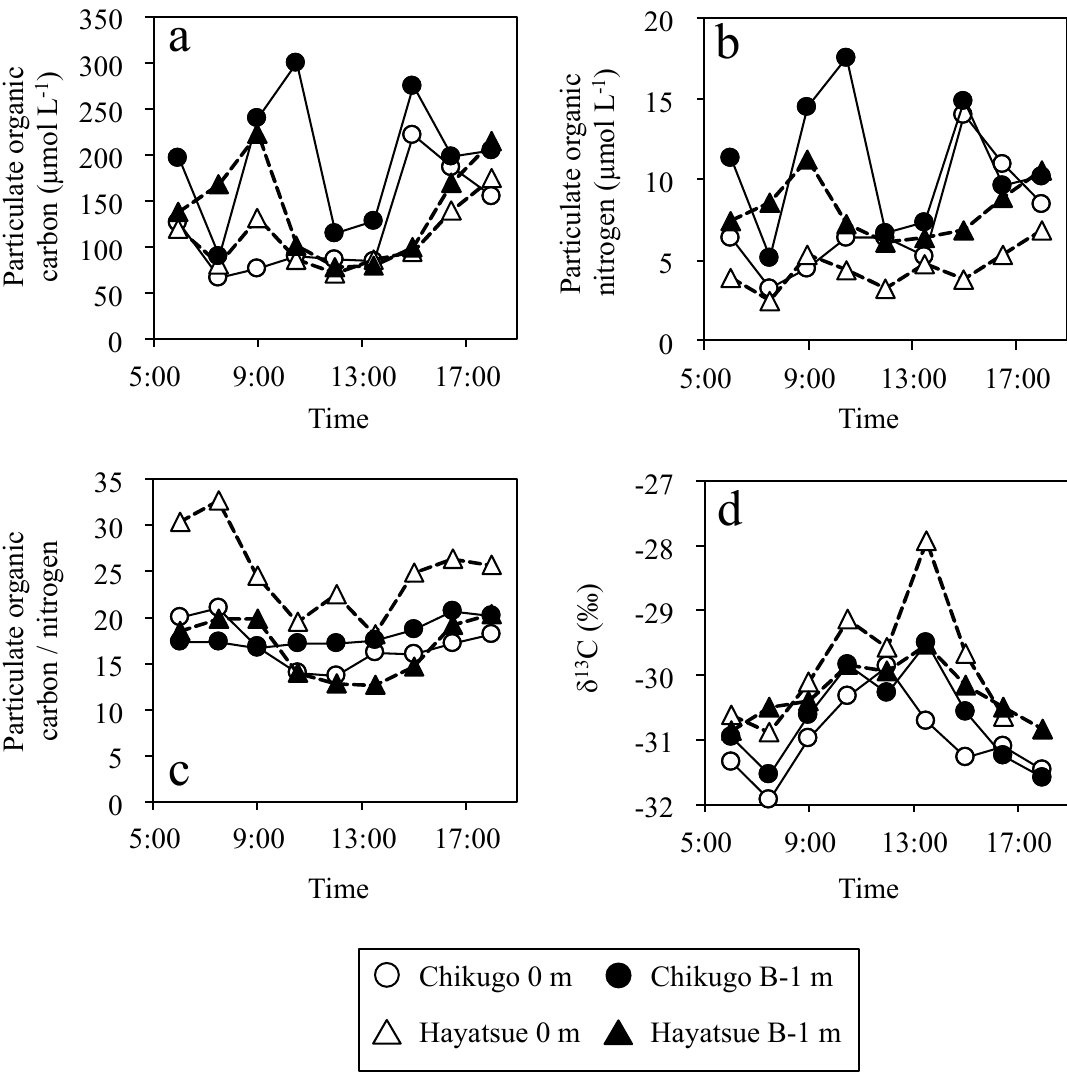
Figure 4. Variations in the ( a ) particulate organic carbon (POC) concentration, ( b ) particulate organic nitrogen (PON) concentration, ( c ) POC/PON, and ( d ) δ 13 C values of POC during the sampling period.